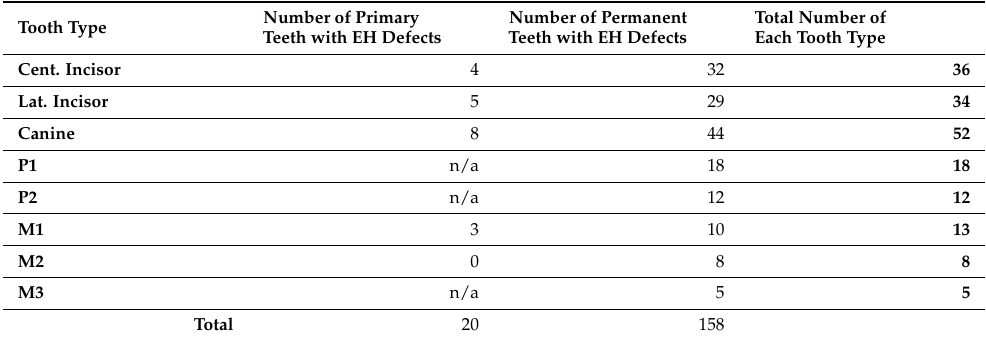
Table 6. The different tooth types affected by enamel hypoplastic defects in the St Mary’s Cemetery